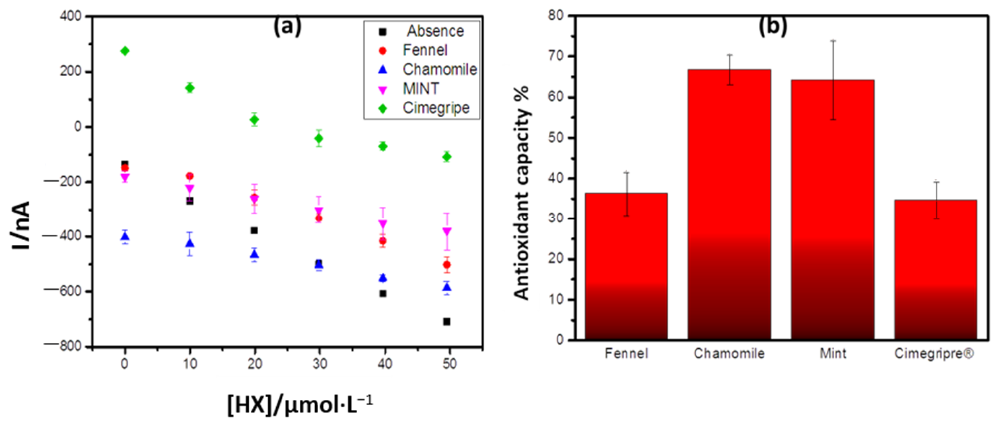
Figure 6. ( a ) Response of the biosensor in the presence of the antioxidant samples. ( b )Antioxidant capacity.